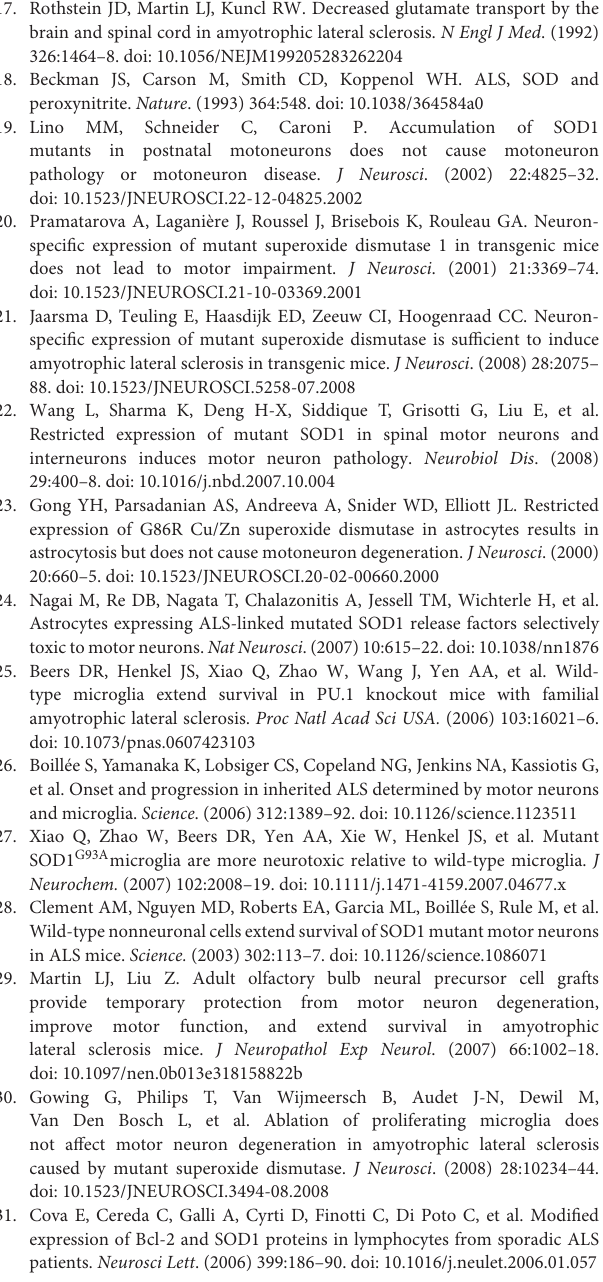
Supplementary Figure 1 | Western blot showing the presence or absence of hSOD1 and presence of mouse SOD1 in different tissues of hSOD1 mus tg mice in generation F10. A very long exposure is shown to ensure the absence of hSOD1 in some lanes. The positive control was a G93A-hSOD1 high expresser mouse line (G1H). hSOD1 was detected in skeletal muscle (hind leg) of all genotypes of hSOD1 mus tg mice. hSOD1 was not detected in CNS tissue (spinal cord). In two mouse lines (only one shown here) hSOD1 was detected in heart. Supplementary Video 1 | Video clip of a live mouse that is a wildtype (WT)- hSOD1 mus tg showing definite complete hind-limb paralysis and hindquarter and lower truncal muscle wasting and